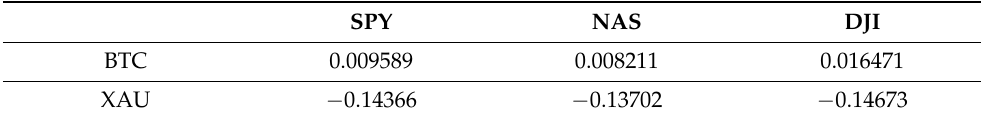
Table 5. Correlation Table for the period October 2017 to February 2020. SPY